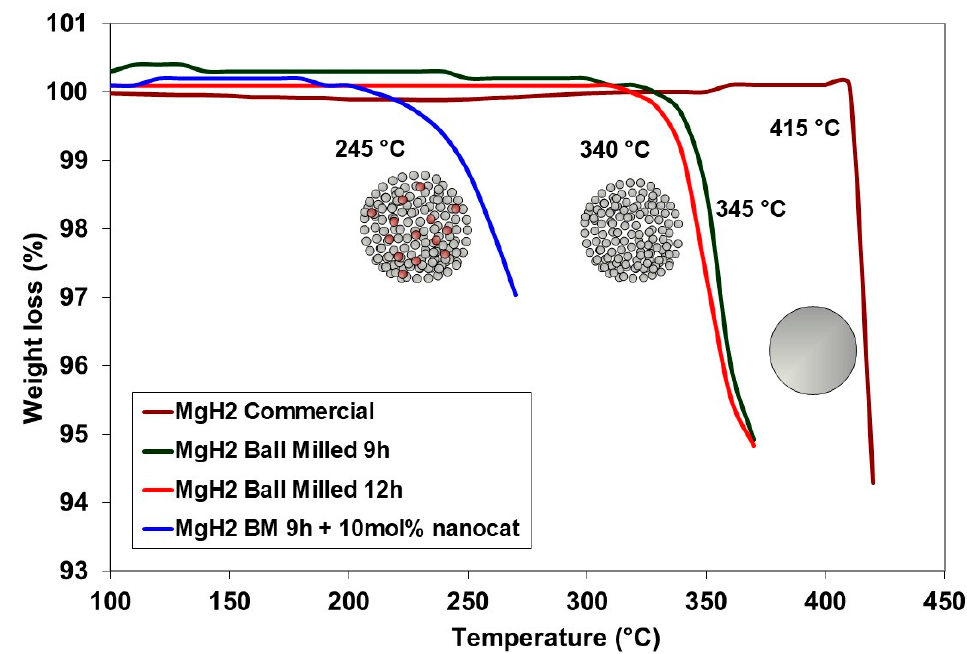
Figure 2. Thermogravimetric hydrogen release profiles of bulk MgH 2 , ball milled (BM) micro / nanocrystalline MgH 2 and nano-Ni catalyst doped micro / nanocrystalline MgH 2 .